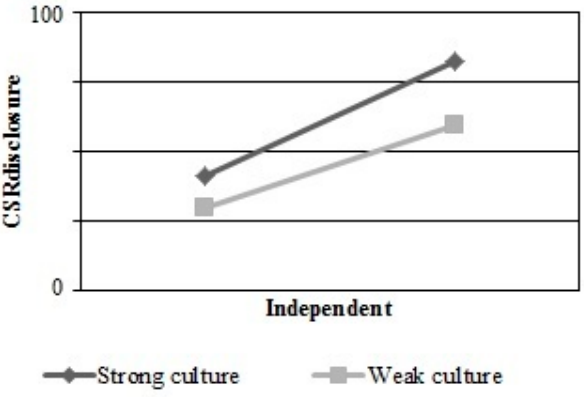
Figure 1. Moderating effect of the cultural context on the link between independent directors and CSR disclosures.